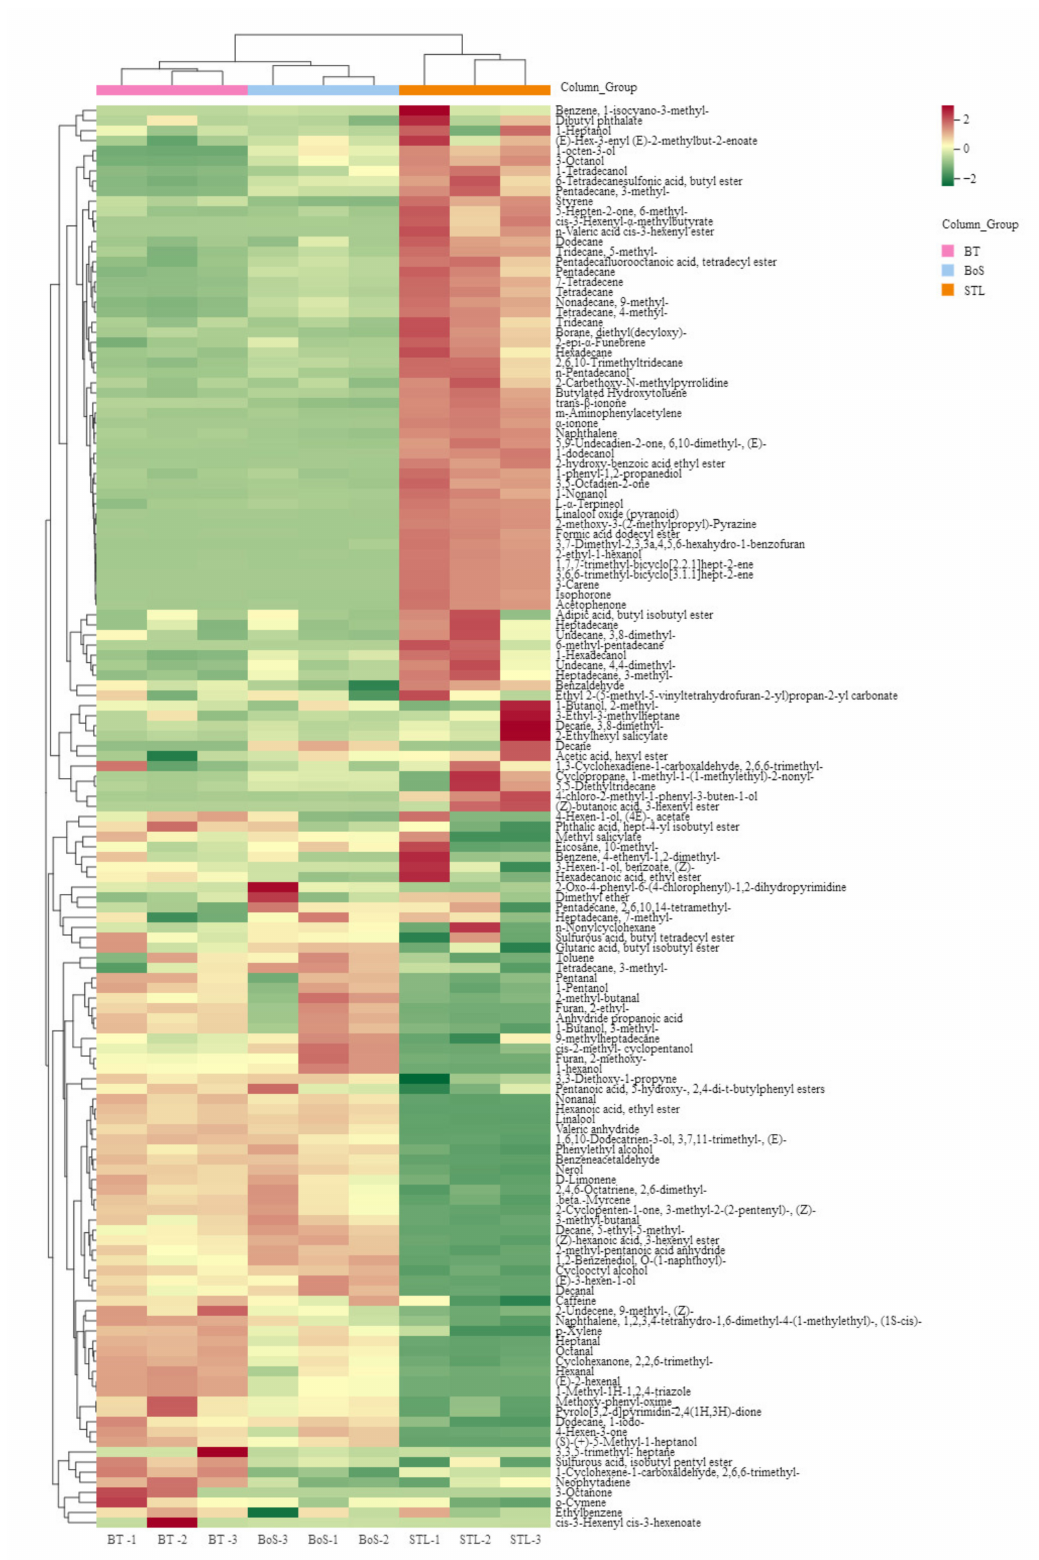
Figure 1. Component analysis showing the thermography of volatile metabolites in BT, STL, and BoS samples. STL, Strobilanthes tonkinensis Lindau; BT, black tea; BoS, black tea with added STL. Red represents high metabolite content, and green represents low metabolite